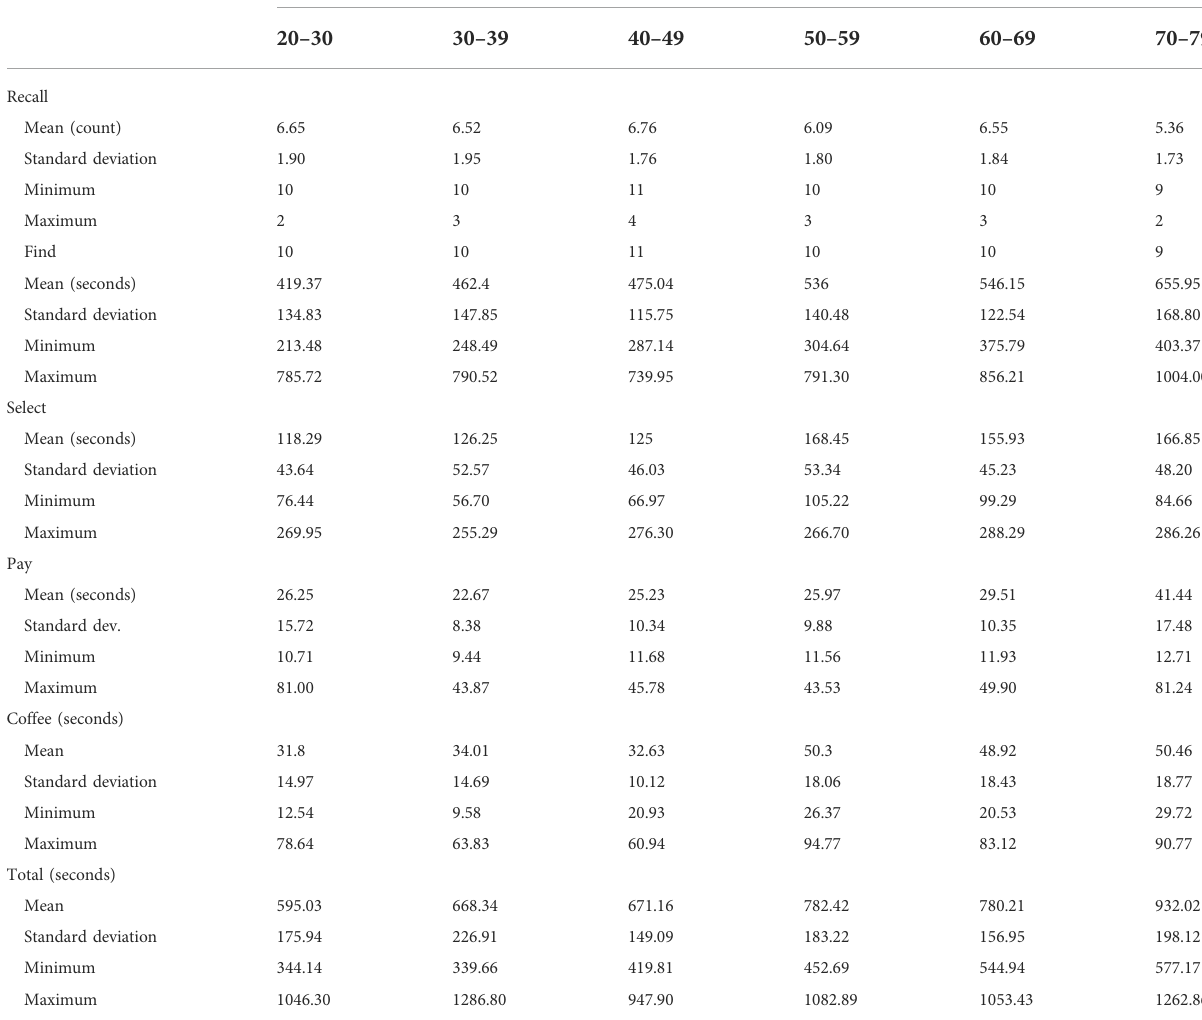
TABLE 2 Study 1 descriptive statistics including means, standard deviations, and range for VStore